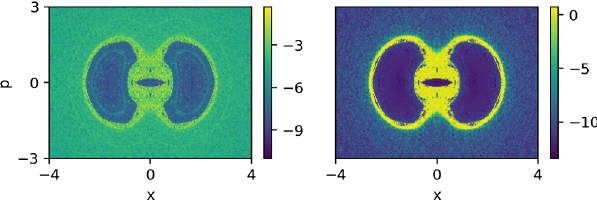
FIG. 9. Dynamic aperture plot using FMA and REM for the tune depression ratio η ¼ 0 . 1 and mismatch X ð 0 Þ ¼ 0 . 577 . The data is taken at every minimum of the envelope for the first 256 times forward and additional 256 times forward to evaluate Δ . Similarly, Δ is measured after 256 times forward and FMA REM then 256 times backward of the envelope period.